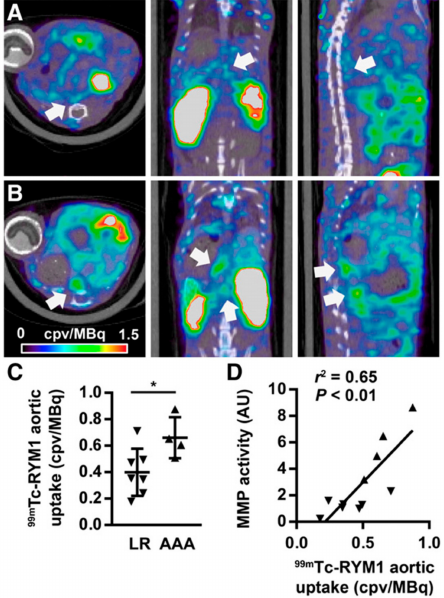
Figure 7. Compound [ 99m Tc] 59 (RYM1) imaging of AAA. ( A , B ) Examples of fused [ 99m Tc] 59 (RYM1) SPECT / CT images of animals from the low remodeling ( A ) and aneurysm ( B ) groups, classified on the basis of a visual in situ analysis of abdominal aorta. Transversal (left), coronal (middle), and sagittal (right) views are shown. Arrows point to areas of maximal tracer uptake in abdominal aorta. ( C ) Quantification of [ 99m Tc] 59 (RYM1) signal in area of maximal tracer uptake in suprarenal abdominal aorta in low remodeling and AAA groups. * p < 0.05. ( D ) Correlation between [ 99m Tc] 59 (RYM1) signal in vivo and MMP activity quantified by zymography ex vivo. AU 5 arbitrary units; cpv 5 counts per voxel; LR 5 low remodeling. Reprinted with permission from [99] copyright © 2017 by the Society of Nuclear Medicine and Molecular